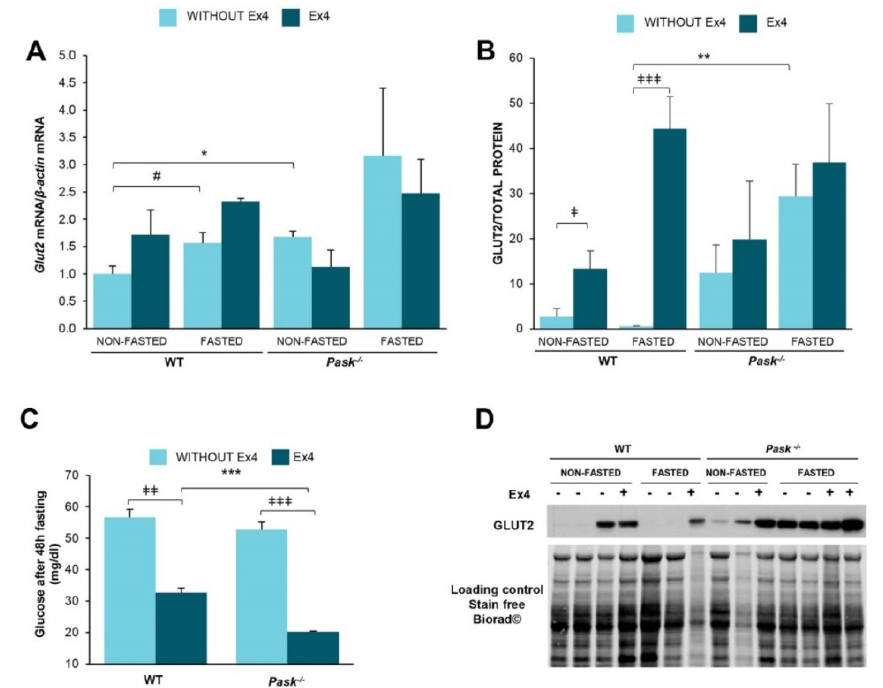
Figure 2. GLUT2 gene expression, protein expression and blood glucose levels altered by exendin-4